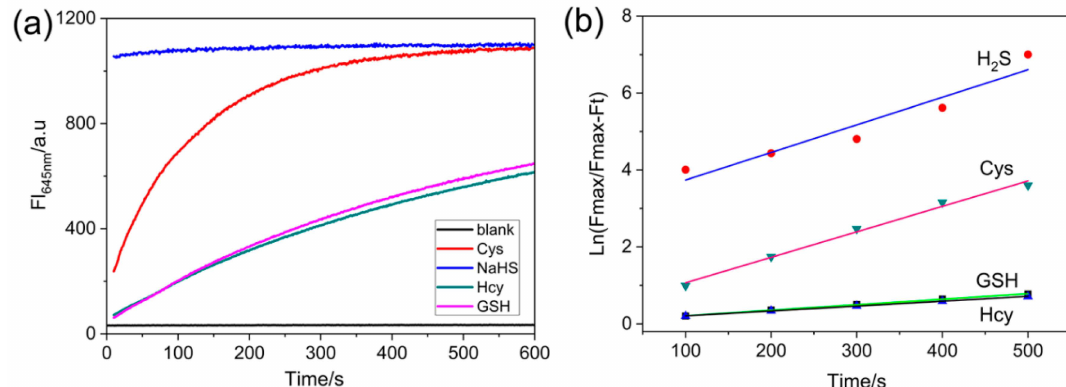
Figure 2. ( a ) Time-dependent fluorescence intensity changes at 645 nm of probe (10 µ M) in the absence or presence of biothiols (30 µ M) in DMSO-Tris / HCl bu ff er (10 mM, pH = 7.4 2:1, v / v ); ( b ) The pseudo-first-order kinetic plot of the reaction of probe (10 µ M) with biothiols (30 µ M). Conditions: incubating in the room temperature for 10 min, slit: excite = emission = 5 nm, λ ex = 567 nm.